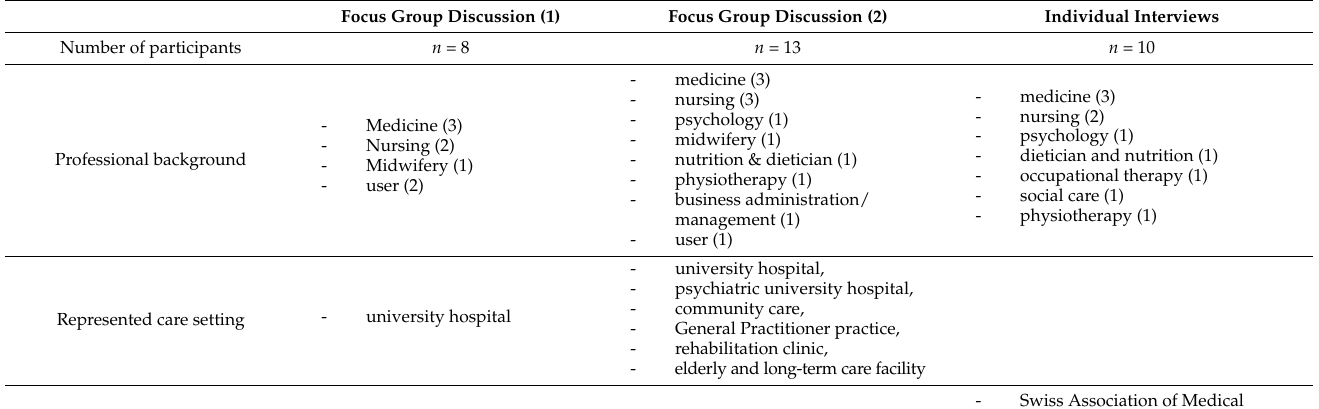
Table 1. Description of study